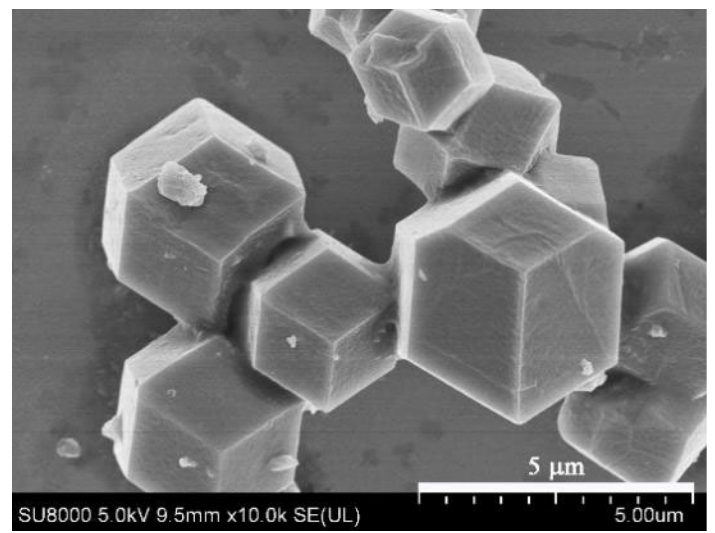
Figure 3. SEM image of MAF ‐ 7 powders.